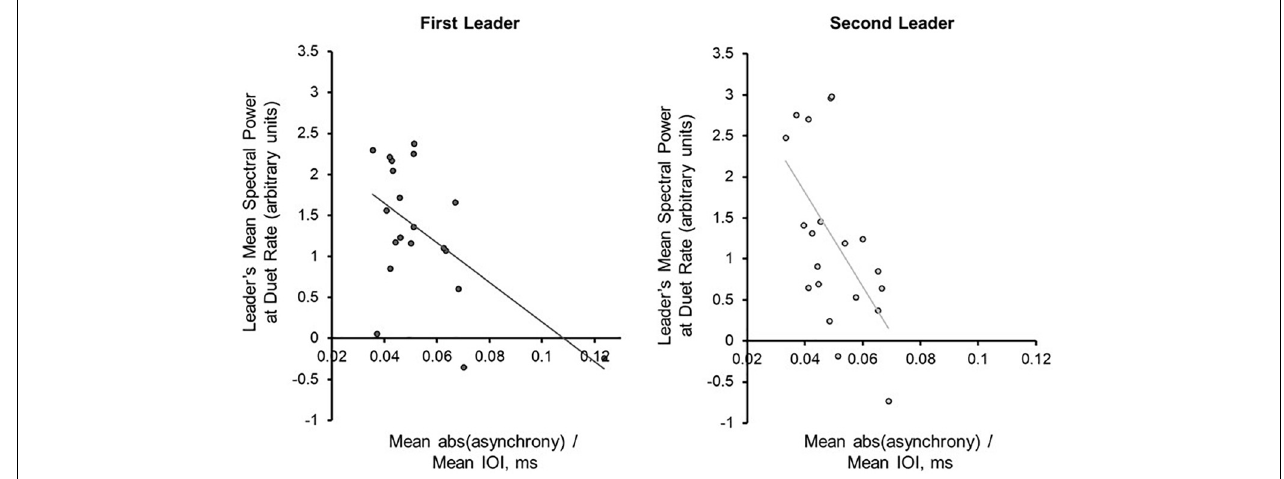
FIGURE 5 | Power Spectral Density at the Duet performance rate is associated with synchronization accuracy. Correlations (with trend lines) of mean duet synchronization accuracy (absolute tone onset asynchrony divided by mean duet IOI) with mean spectral power at the Duet performance rate in the First-Leader (left) and Second-Leader (right) Duet conditions. Each dot represents one